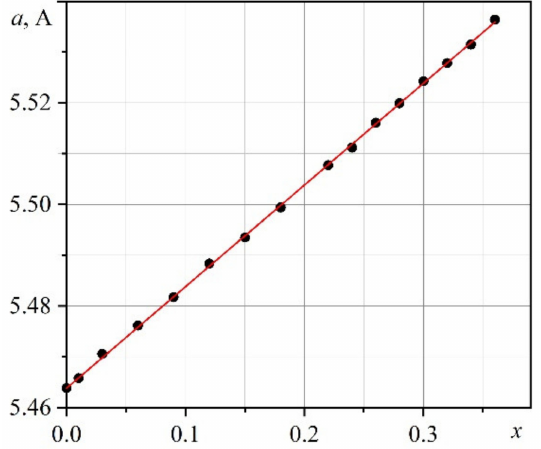
Figure 5. Concentration dependence of the lattice parameter of Ca 1– x Y x F 2+ x .